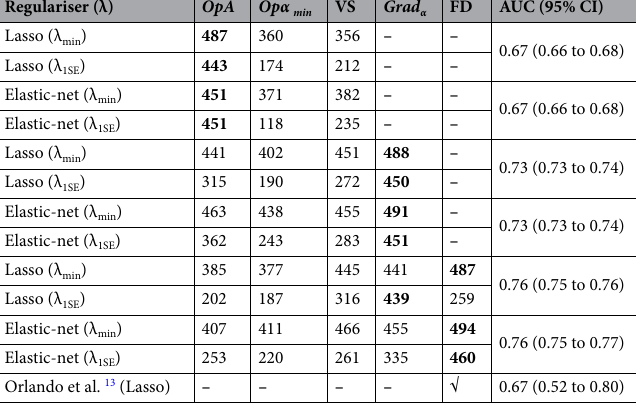
Table 2. Relative feature importance. Relative feature importance calculated by the number of times a feature reached a non-zero coefficient per bootstrap, average bootstrap performances and performances reported in 13 using fractal dimensions to detect PDR. Bold indicates the most important feature. CI confidence intervals, AUC area under curve.